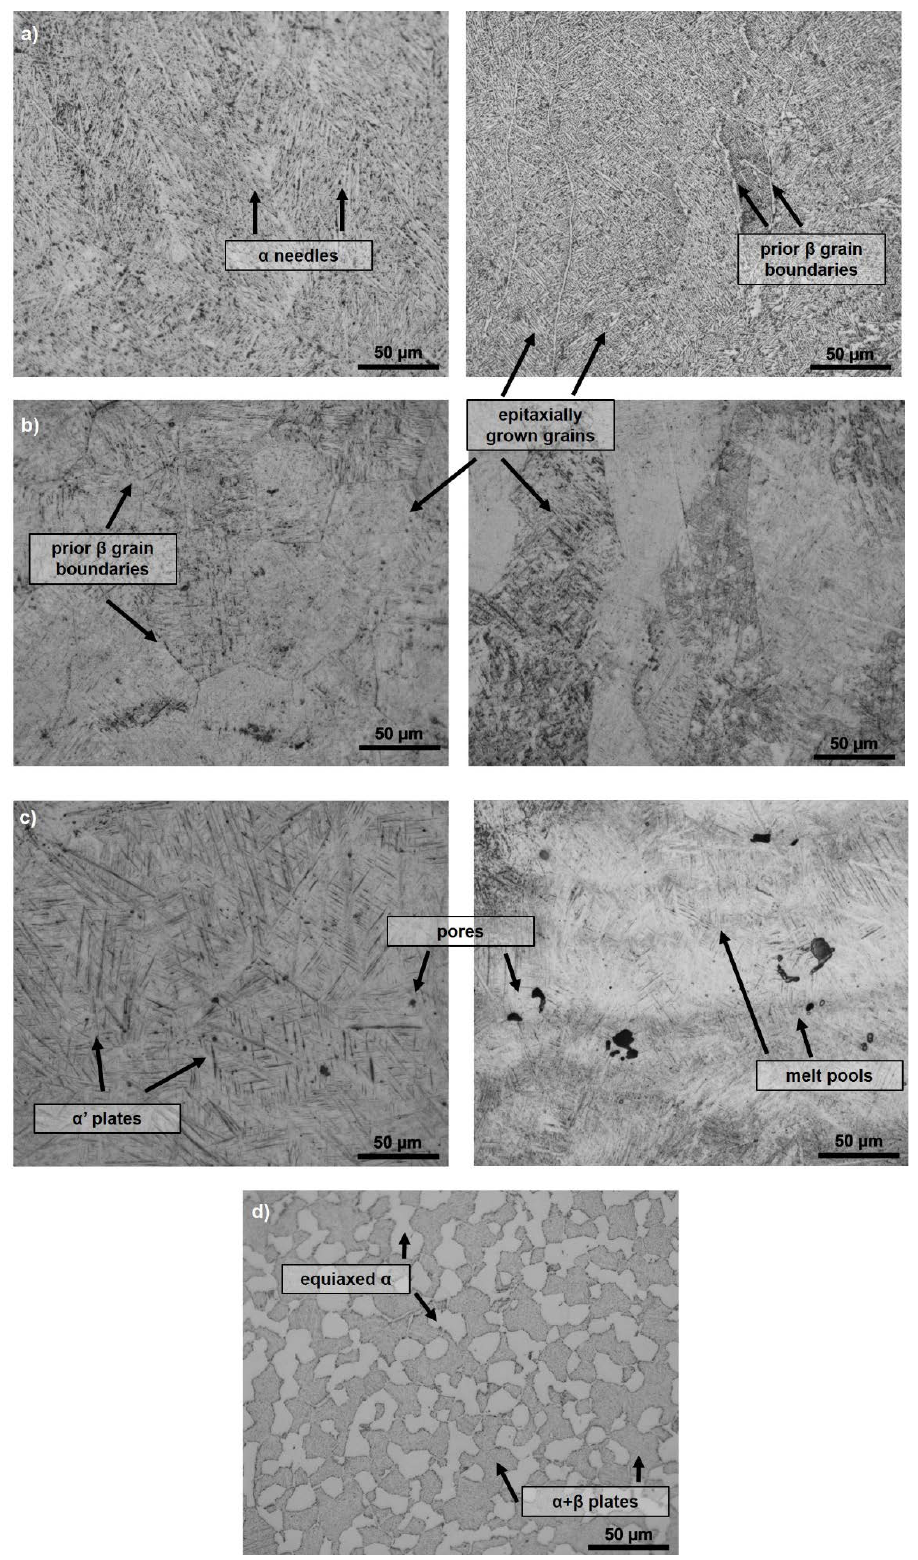
Figure 4. Light optical microscope images of the XY (left side) and XZ (right side) cross-sections in the produced samples; ( a ) EBM fabricated sample; ( b ) SLM-fabricated sample length during optimization (5-mm side); ( c ) SLM-fabricated sample (15-mm side); ( d ) the control specimen, which was a wrought Ti-6Al-4V alloy sheet.